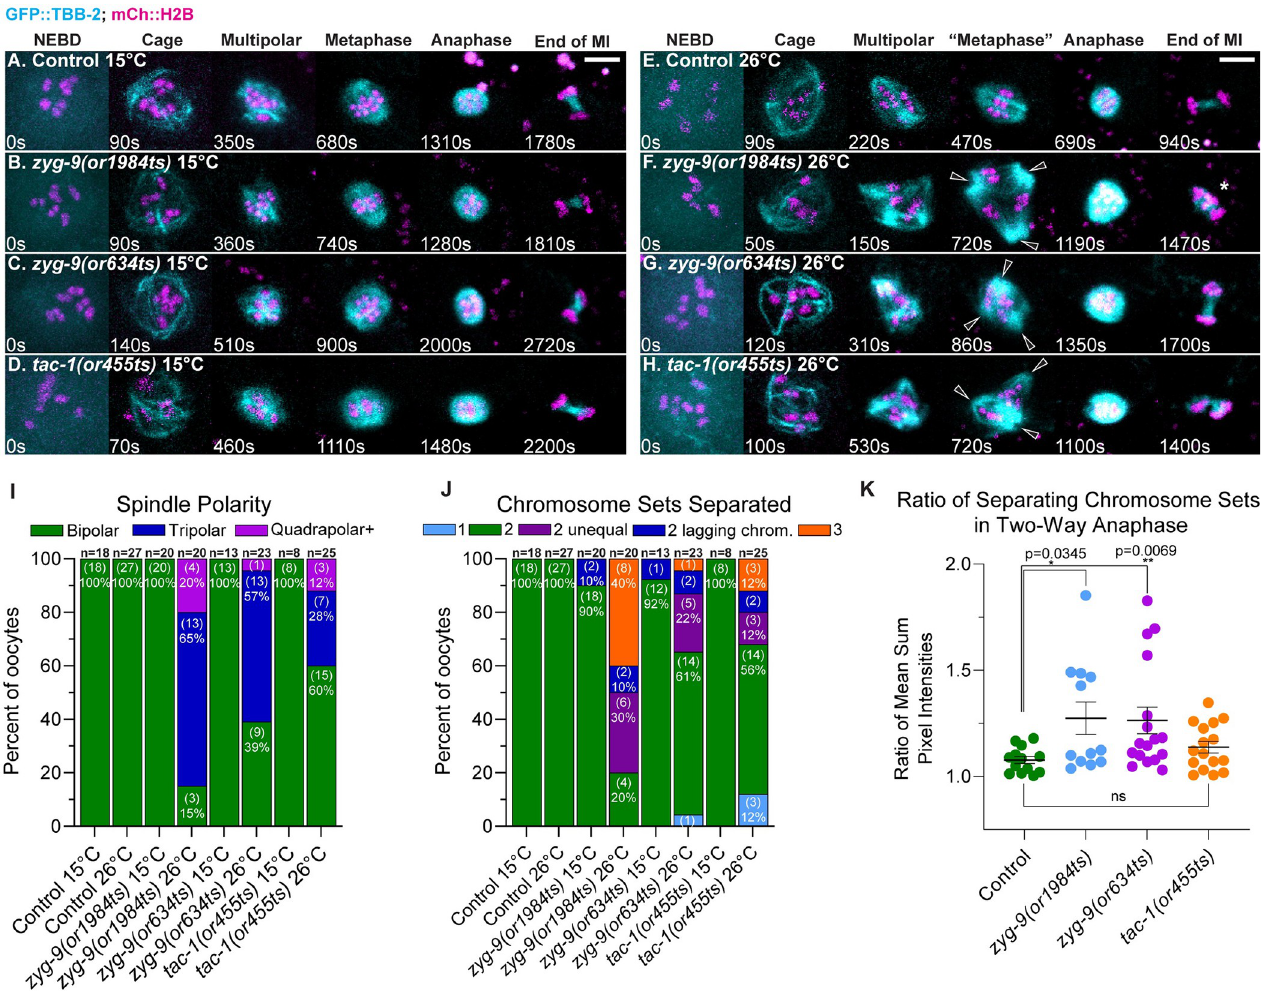
Fig 1. Oocyte meiosis I spindle assembly dynamics in zyg-9 and tac-1 TS mutants at the permissive and restrictive temperatures. (A-H) Time-lapse maximum intensity projection images during meiosis I in live control and TS mutant oocytes expressing GFP::TBB-2 and mCherry::H2B to mark microtubules and chromosomes, at 15˚C (A-D) and at 26˚C (E-H). In this and in all subsequent meiosis I time-lapse image series, t = 0 is labeled NEBD and is the timepoint immediately preceding the appearance of microtubule bundles forming the cage structure. To account for differences in movie signal quality inherent to in utero live cell imaging, the intensity scales for montages in all figures were set individually to give the clearest depiction of the spindle and chromosomes (see Materials and Methods). (I-J) Number of spindle poles present at the onset of spindle shortening per oocyte (I), and number of chromosome sets separated after anaphase per oocyte (J); number of oocytes examined indicated above each bar, number scored with each phenotype shown in parentheses inside bars with corresponding percent below. (K) Ratio of fluorescence intensity of two separated chromosome sets at 26˚C (see 1J) at the end of anaphase B. For all figures, distributions of scatter plot values were compared using the Mann–Whitney U-test to calculate P-values (S2 Data). Error bars and values are mean ± SEM. � , P < 0.05; �� , P < 0.01. Scale bars = 5 μ m. Oocytes with extra poles indicated with hollow arrowheads. See the Materials and Methods for a description of the spindle assembly stages and frame selection in this and all other figures. Oocyte with chromosomes separated into three sets indicated with an asterik.